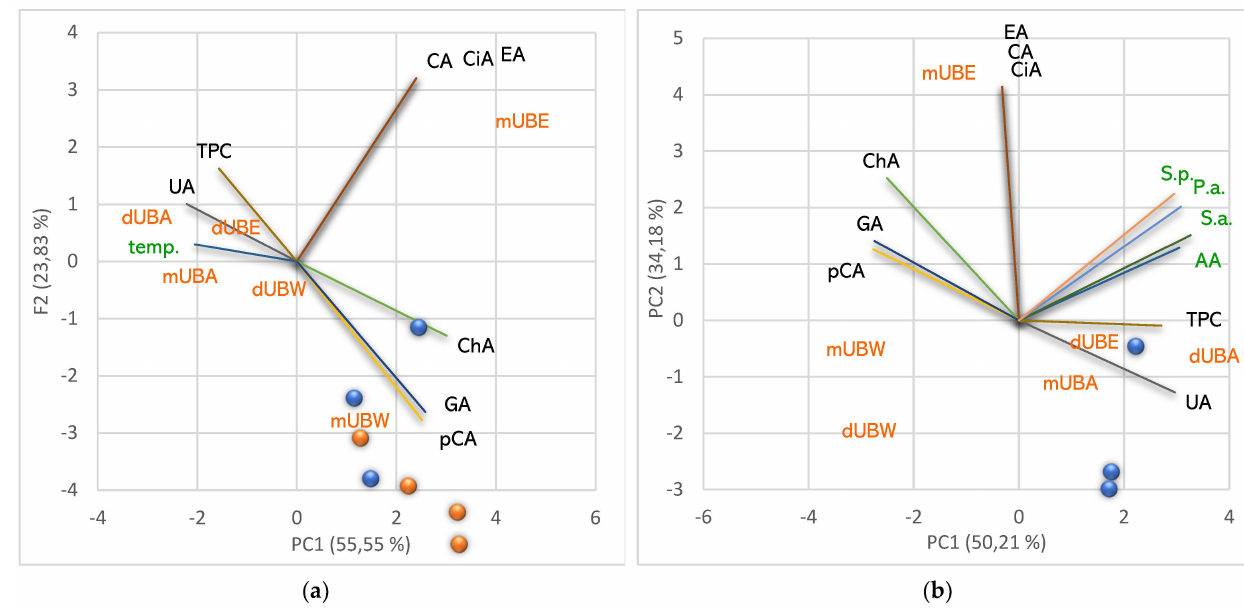
Figure 11. Characterization of U. barbata extracts by positioning each lichen extract according to its phenolic metabolites correlated with temperature ( a ) and bioactivities ( b ). pCA— p